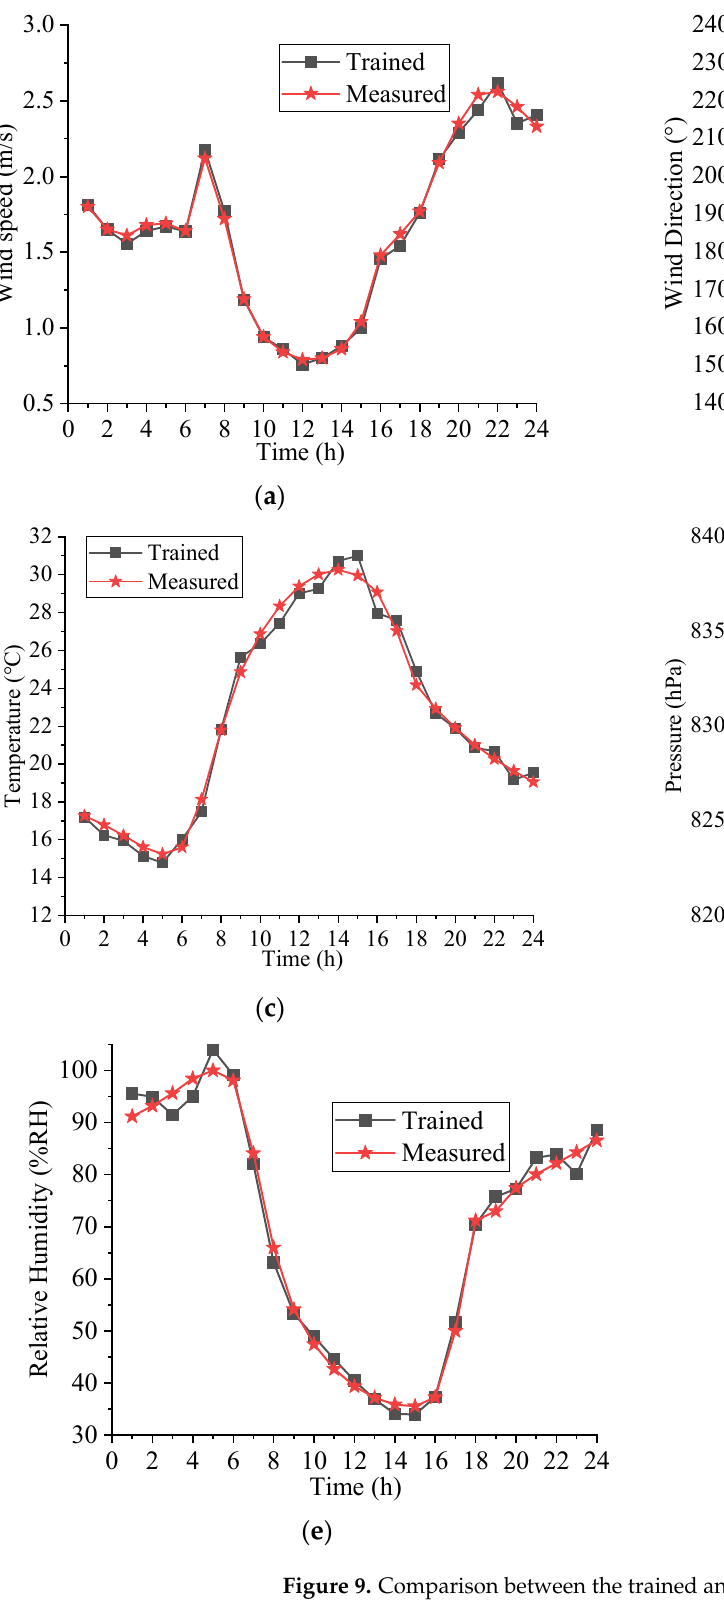
Table 7. Error of each prediction model.